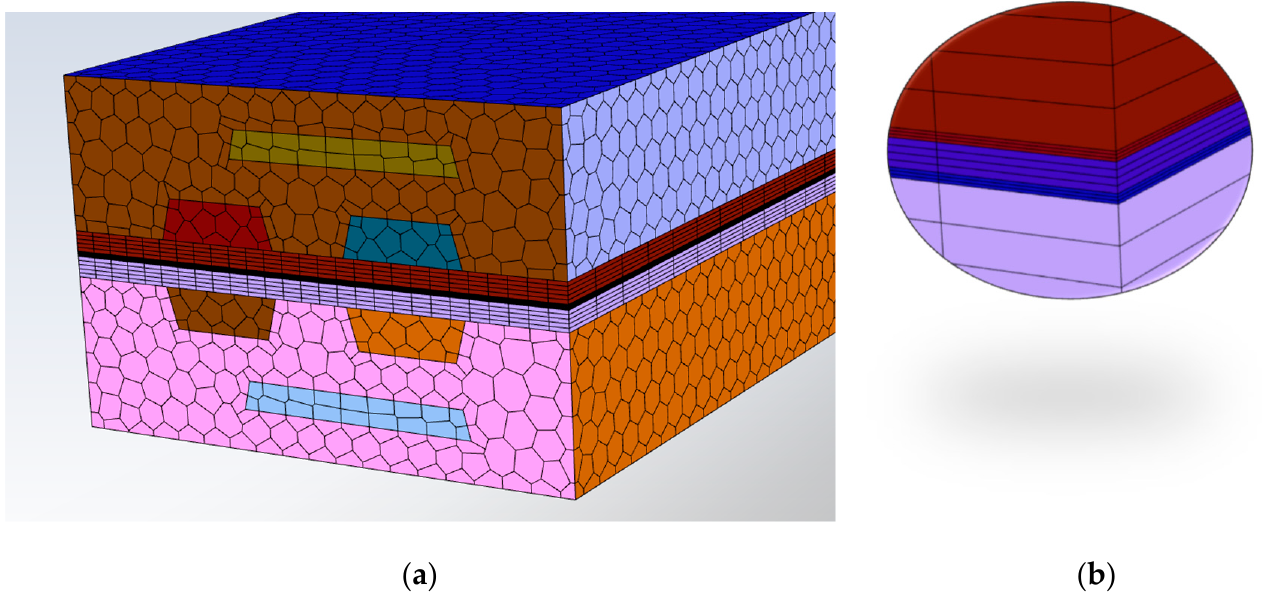
Figure 2. Mesh division of PEMFC. ( a ) Mesh of overall structure; ( b ) Mesh of catalytic layer and membrane.